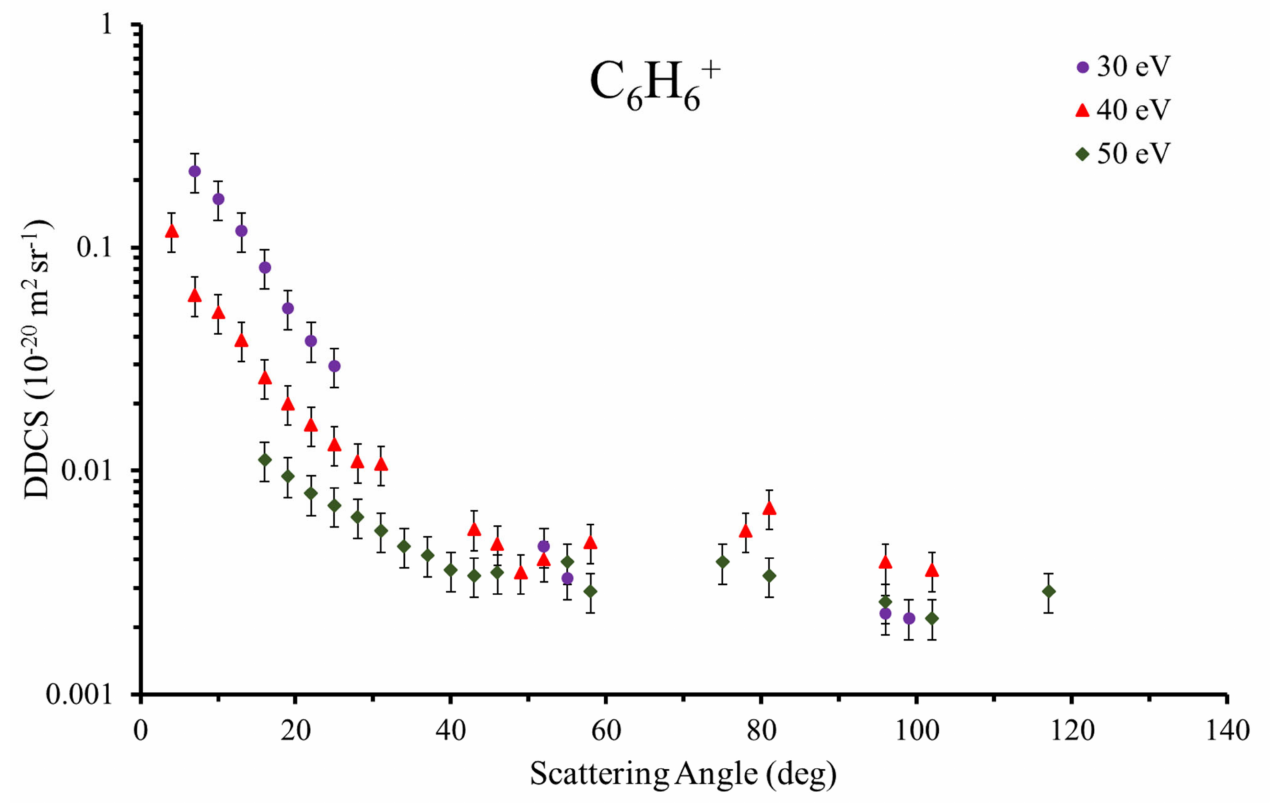
Figure 1. Experimental absolute double differential cross sections (DDCS) for producing the ion parent of benzene (C 6 H 6+ ) at 90 eV of impact energy for different transferred energies (30, 40, and 50 eV).